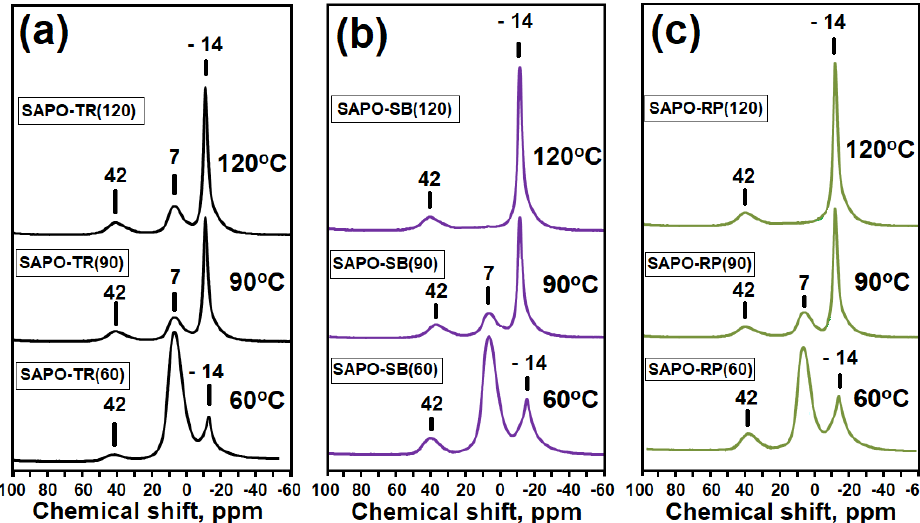
Figure 7. MAS NMR 27 Al spectra of initial silicoaluminophosphate gels prepared using various